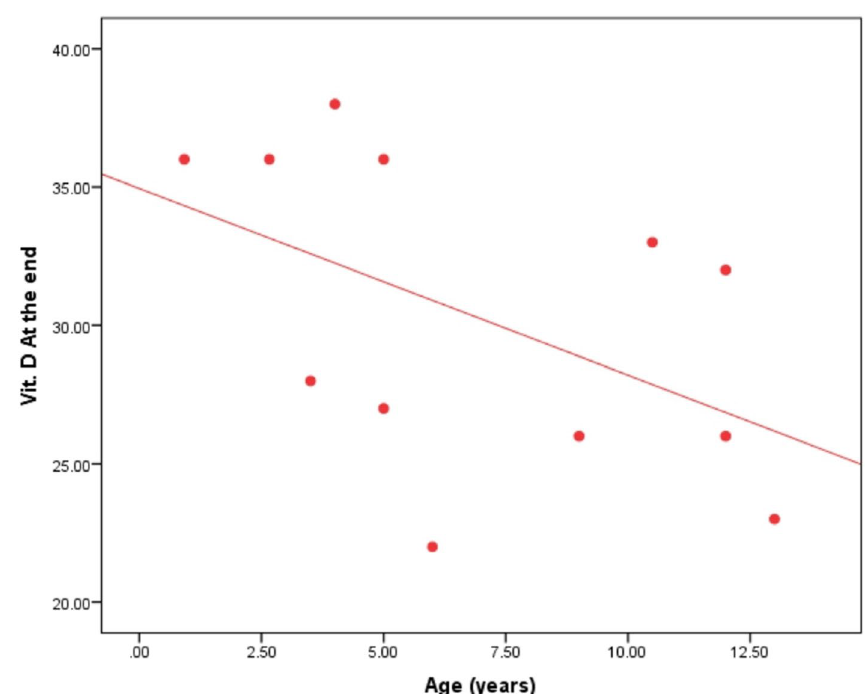
Fig. 1 A negative correlation relation between patient’s age and the level of vitamin D difference in group